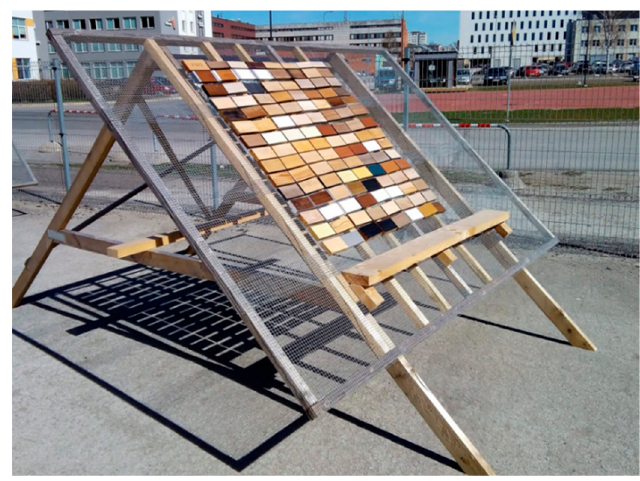
◦ 23 (cid:48) 50.6” N 24 ◦ 39 (cid:48) 24.0”